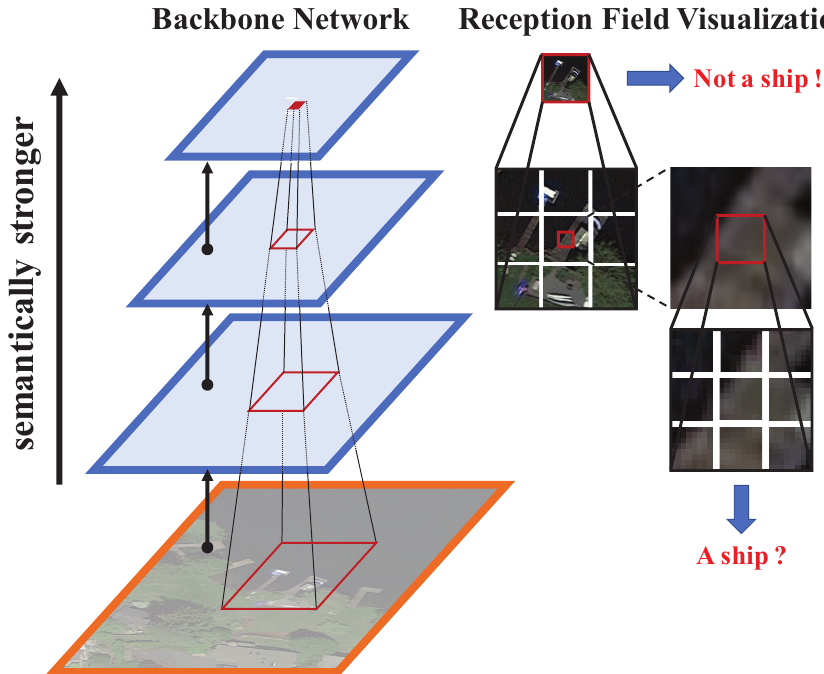
Figure 5. Visualization example of reception field. Along with the bottom-up backbone network, the filters in higher layers correspond to the larger reception fields, and thus, the output features of higher layers are semantically stronger. As shown in the example, we cannot confirm whether it is a ship based on low-layer features, while it is easy to confirm it is not a ship based on high-layer features. JFW is the core component of the proposed JRFP, and can narrow the semantic gap by fusing and liberating all of the feedback signals jointly. The structure of JFW is shown in Figure 6. The input of JFW is the feedback signals from pyramid levels, and its outputs are connected to the corresponding stages in the backbone network. As the shapes of features vary at different levels, up-sampling operations are needed to make all of the input features uniform, and down-sampling operations are needed to recover the processed features into the corresponding shapes. In addition, channel numbers in pyramid levels are different from those in the backbone network, and thus down-sampling operations are followed by 1 × 1 convolutional layers, which are used to adjust channel numbers to match